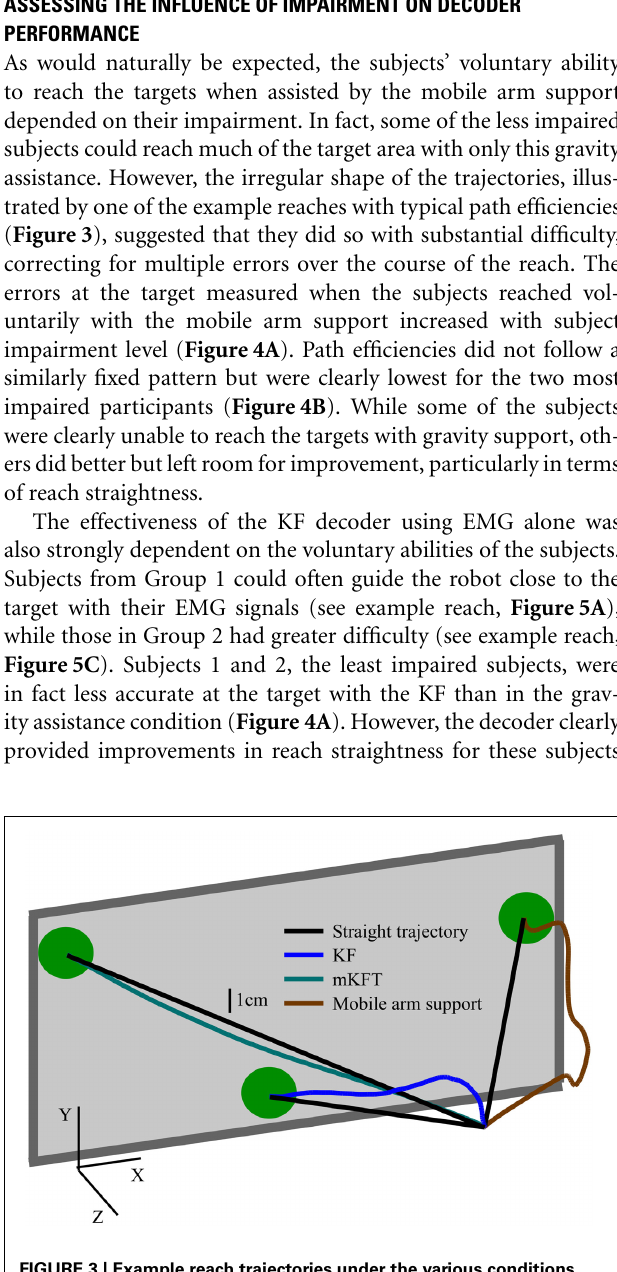
FIGURE 3 | Example reach trajectories under the various conditions with typical path efficiencies. Kalman Filter (KF)—94.2%; mixture of KFTs (mKFT)—99.7%; Voluntary with mobile arm support providing support against gravity—67.5%. All reaches are by Subject 3. The monitor is for illustration purposes and is not to